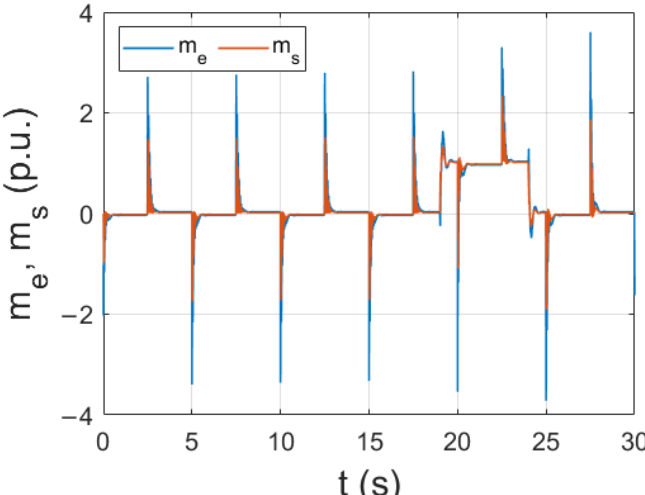
Figure 4. Operation of the drive under nominal conditions—electromagnetic ( m e ) and torsional ( m s ) torques.